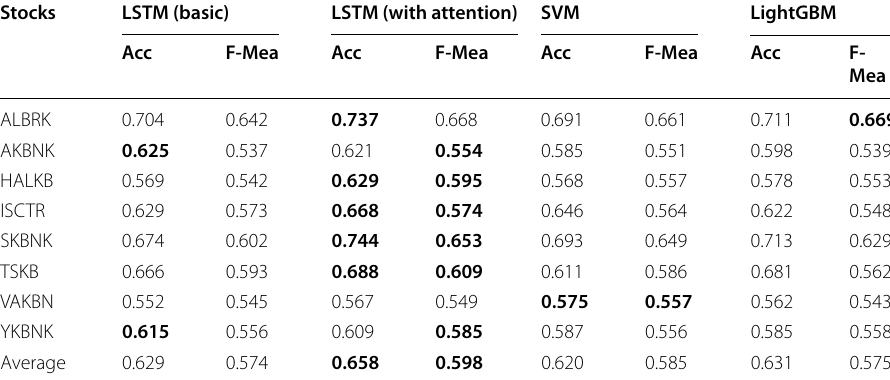
Bold numbers indicate the best performance